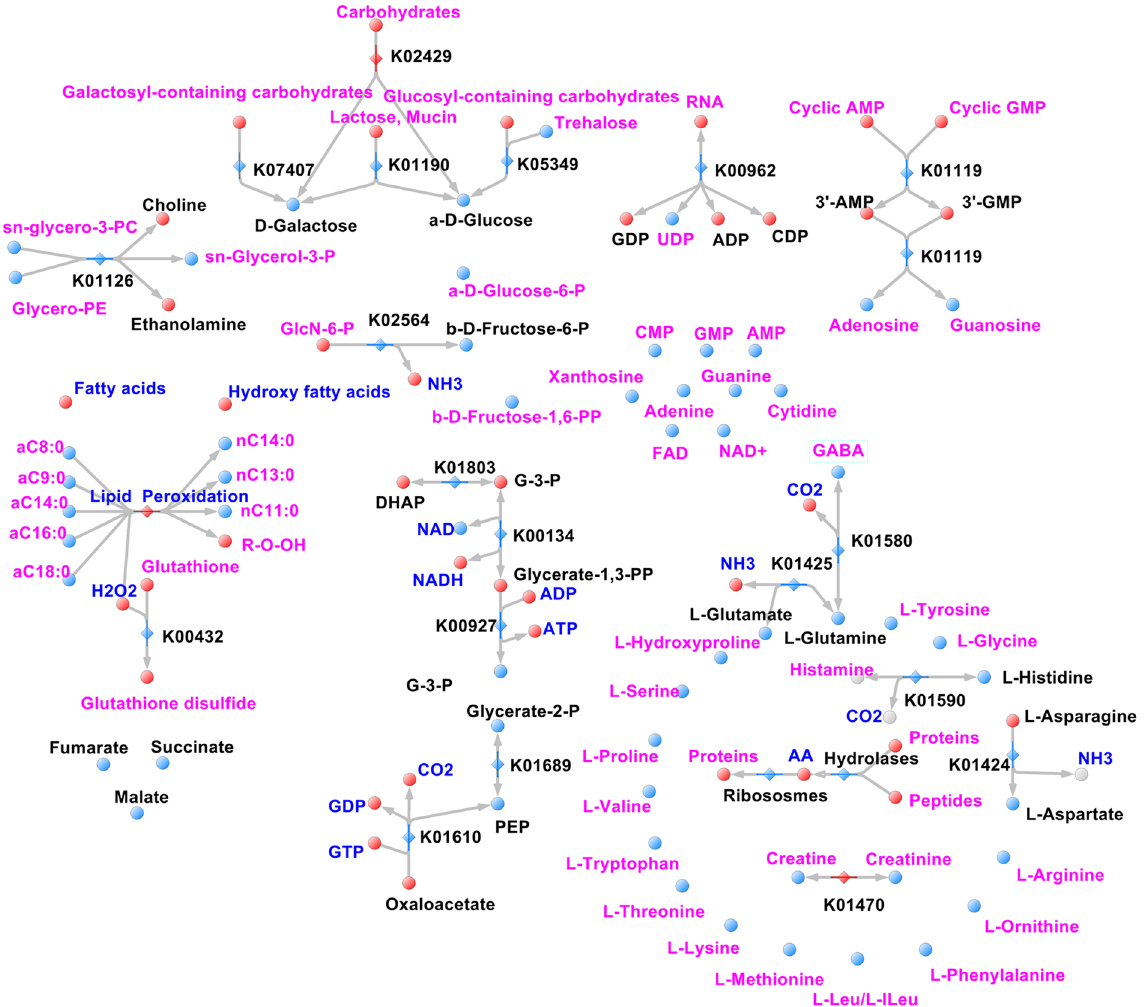
Figure 8. Reconstructed metabolic maps of NTBF OMVs. Metabolites that are identified/not identified are colored in blue/red spheres. The blue/red rhombus indicates the identified/not identified enzymes. The main reconstructed pathways are shown in the